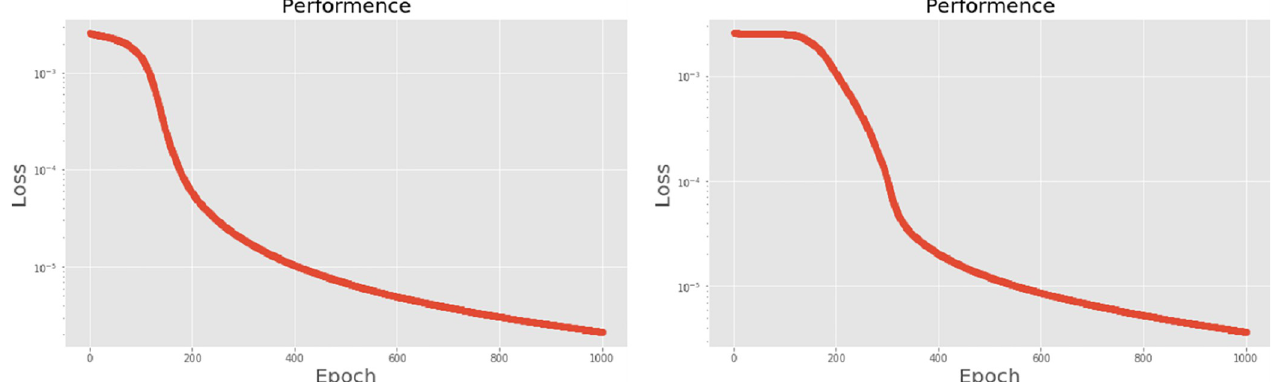
Fig 27. (a) The graph shows the performance of MFCC-LSTM-2 × 500 model; (b) The graph shows the performance of MFCC-PCA-LSTM-2 × 500 model.